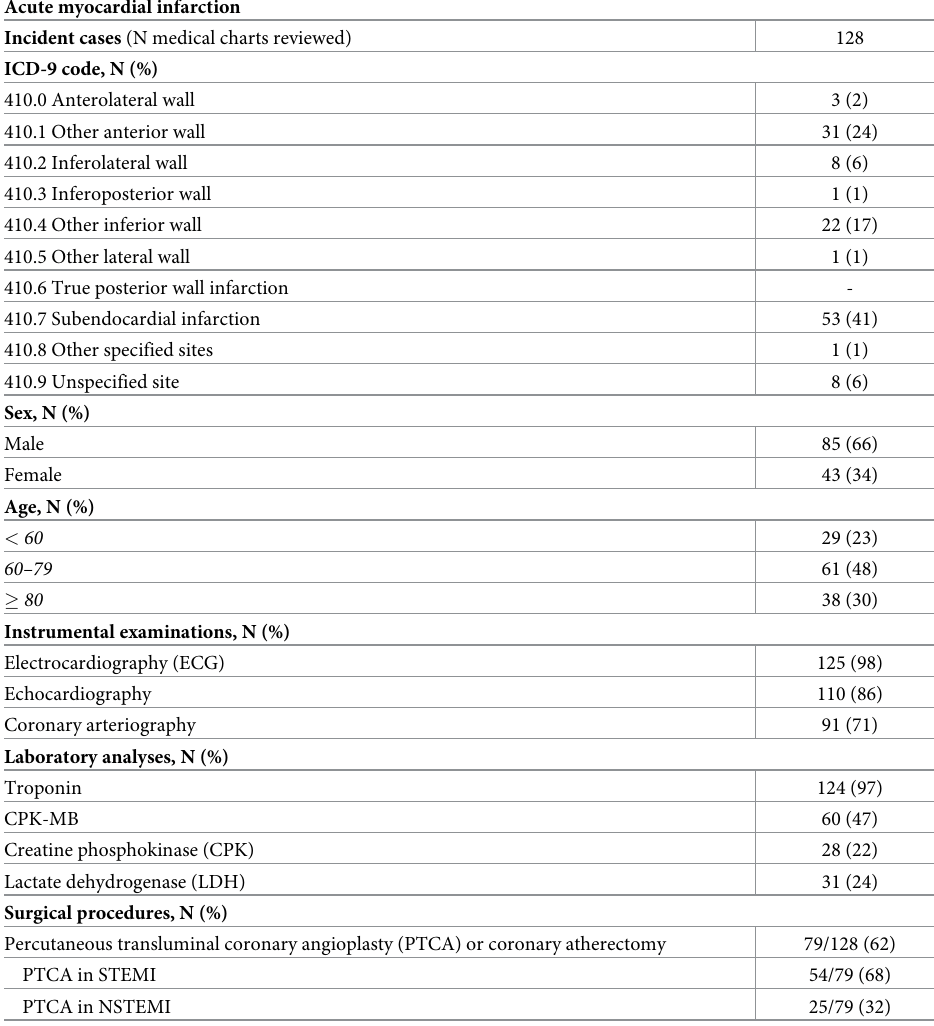
Table 1. Characteristics of patients with acute myocardial infarction who were identified in the Regional Admin- istrative Database of